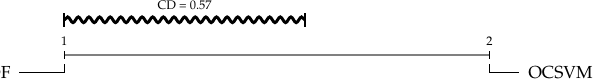
Figure 7. Critical Difference chart of Recall performance between LOF and OCSVM across all attack patterns and magnitudes ( (cid:101) ). It is possible to observe that there is no link between the first and second techniques, which demonstrates a significant difference between OCSVM and LOF, with LOF as the superior one.